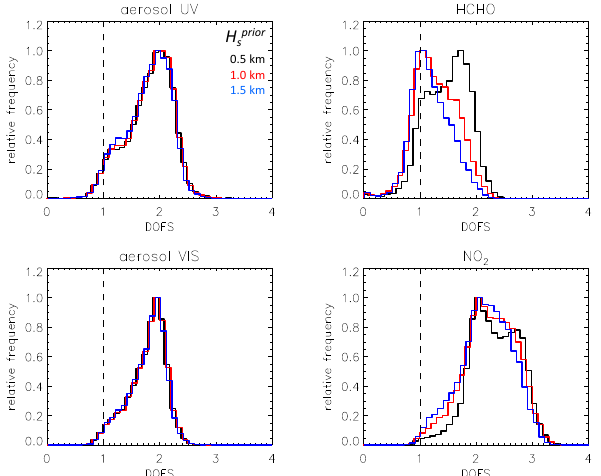
Figure 3. Histograms showing the degrees of freedom for signal (DOFS) for the profile fits obtained with methods A1–A3, based on all MAX-DOAS scans analysed for the Xianghe station. The up- per row shows results for the UV, the bottom row shows results for the Vis. The dashed line indicates the threshold that is used for the quality control: retrievals with DOFS < 1 are excluded from the